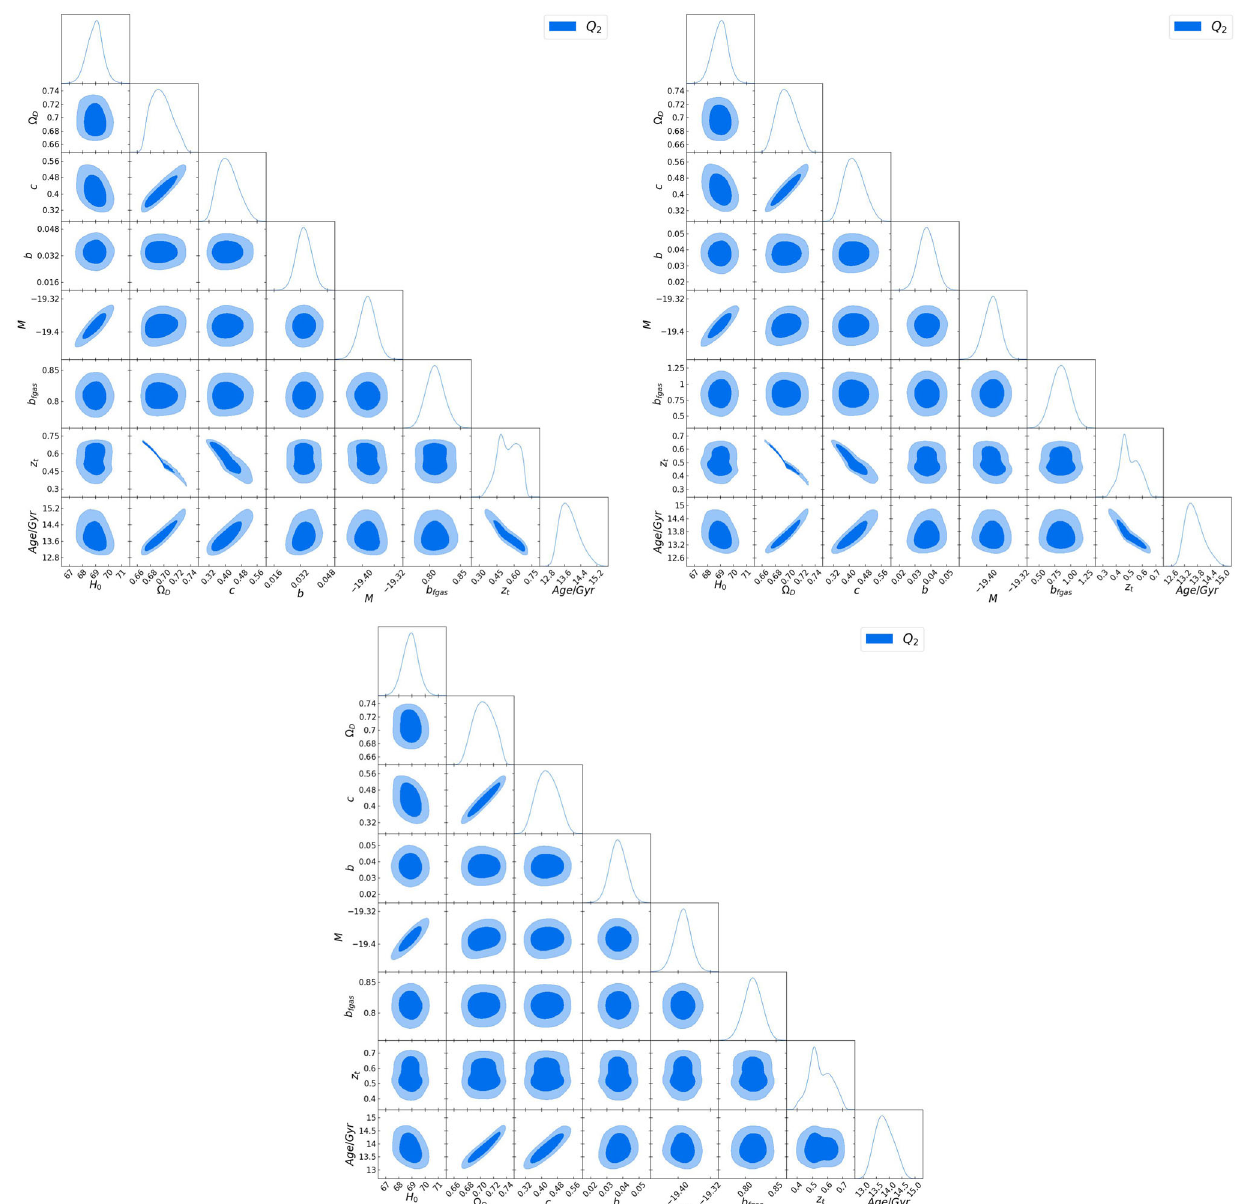
Fig. 7 The contour maps of the HRDE (see Eqs. (15) and (16)) with three types of linear interaction Q 1 , Q 2 and Q 3 listed in Table 1. In this figure H 0 is the Hubble parameter, (cid:5) D is the dark energy density, α = c 2 is the dimensionless parameter, b is the coupling constant, M